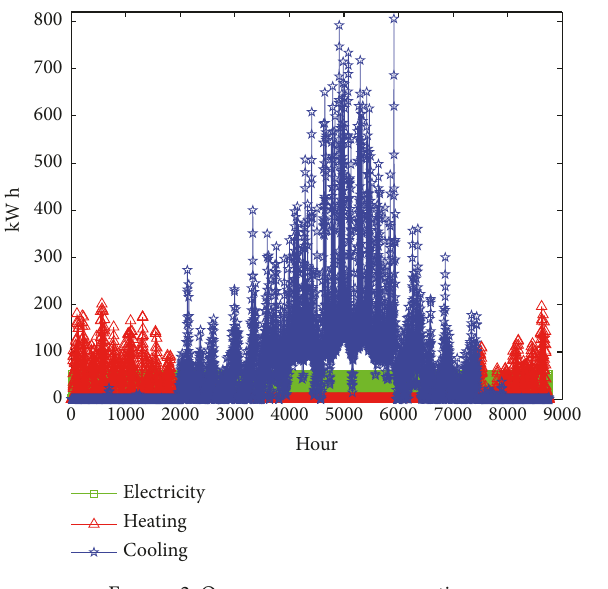
Figure 2: One-year energy consumption.